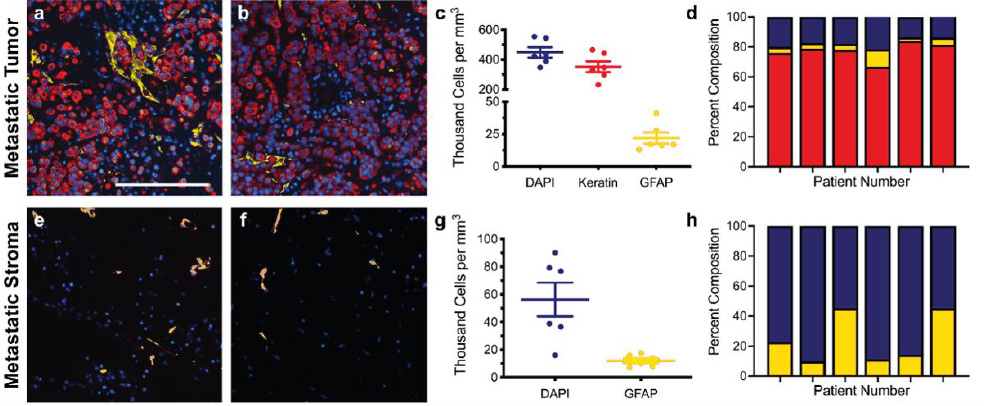
Figure 2. Staining and cellular quantification of metastatic breast cancer resections . Breast cancer brain metastases patient resections were stained for breast cancer cells (anti-pan keratin; red), activated astrocytes (anti-GFAP; yellow), and total cells (DAPI; blue). The number of positively stained cells for each channel was counted in five random regions in order to determine the cell densities and percent compositions within the tumor ( a – d ) and within the stroma ( e – h ) for six patients ( n = 6). Scale bar = 200 μm.